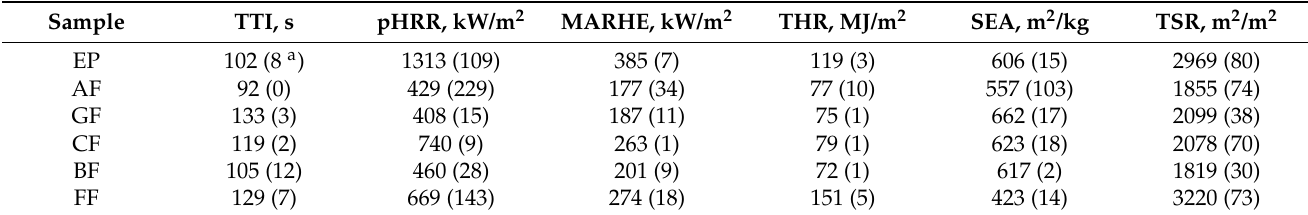
Table 3. Cone calorimeter results of EP and EP-based composites.